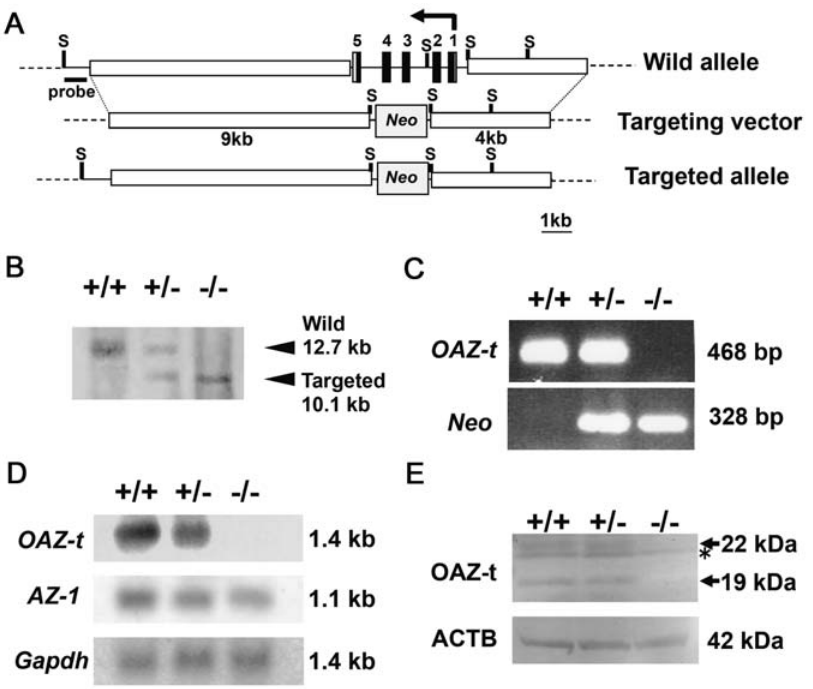
Figure 1. Generation of OAZ-t knockout mice. (A) Schematic representation of the methods used for gene targeting of the OAZ-t genome. The gene targeting construct contains Neo (open box) between the 4-kb 5 9 -arm and 9-kb 3 9 -arm (thick lines). As a result, exons 1–5 were replaced with Neo . Exon 1 includes the first methionine. Arrows indicate the transcriptional direction of OAZ-t . S indicates Sac I restriction sites. (B) The targeted allele was identified by the Southern blotting of genomic DNA digested with Sac I using a probe created from the 3 9 fragment. (C) The mice were genotyped by PCR using two sets of primers: one set for the amplification of the Neo gene ( Neo ) and one set for the amplification of the OAZ-t gene. + / + : wild-type; + / 2 : heterozygous mutant; 2 / 2 : homozygous mutant. (D) Analysis of gene expression by northern blotting. No OAZ-t transcripts were detected in the testes of OAZ-t homozygous mutant mice. The same membrane was rehybridized with AZ-1 or Gapdh cDNA as a control. (E) Western blotting of testicular lysates from adult mice using anti-OAZ-t polyclonal antibodies. OAZ-t was not detected in the lysates from the homozygous mutant mice (22 kDa). The 19-kDa band may be a degradation product of OAZ-t. The asterisk indicates a non-specific band. b -Actin (ACTB) was used as a